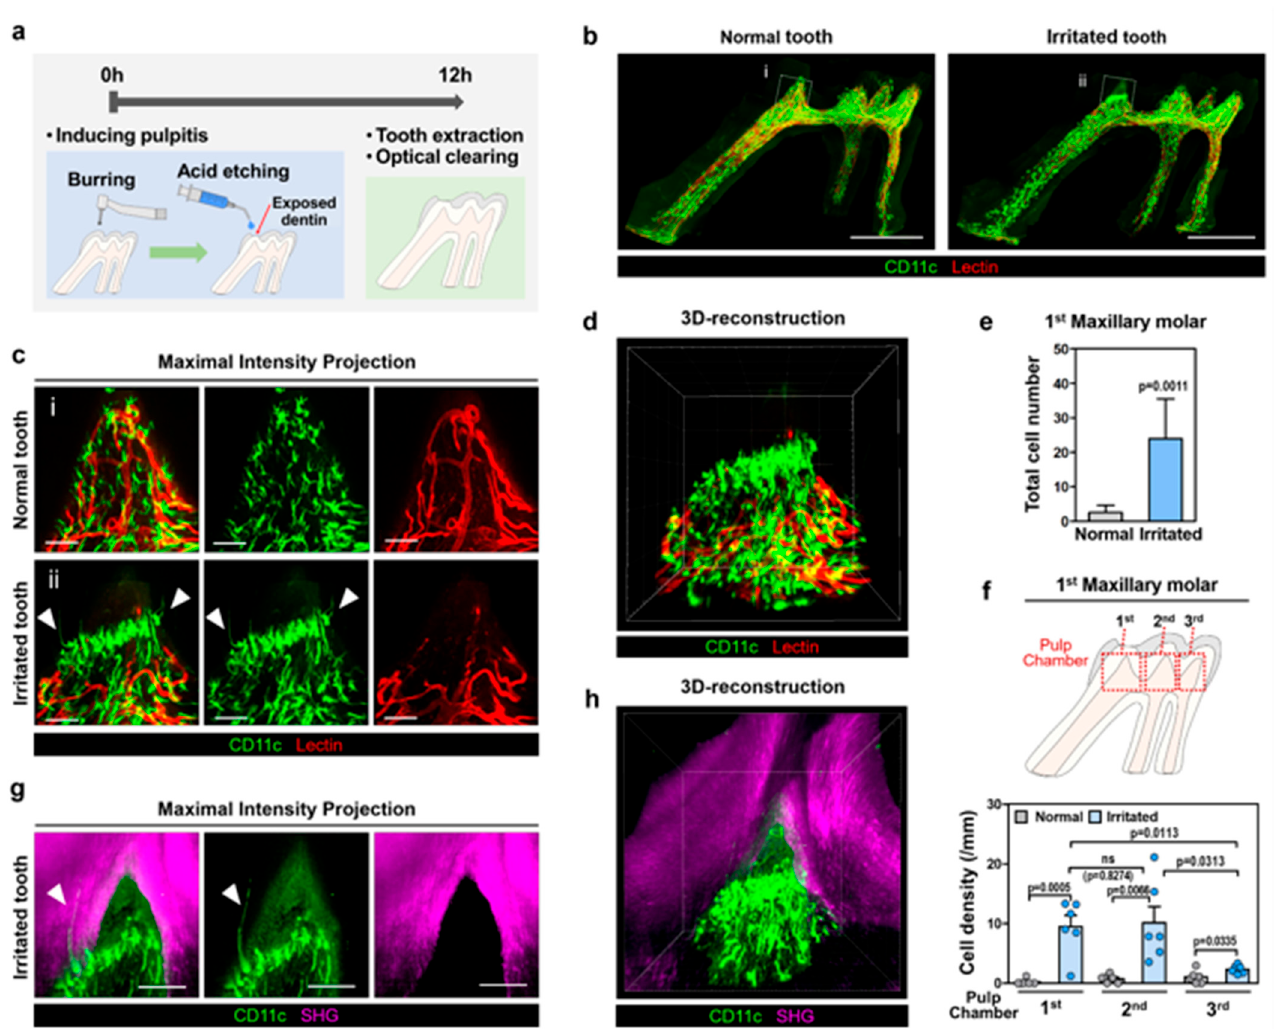
Figure 3. 3D cellular-level visualization and quantification of CD11c+ cells after acute pulpitis induction. ( a ) Schematic illustration of acute pulpitis induction. ( b ) Maximal intensity projection images of normal and irritated tooth extracted from CD11c-YFP transgenic mouse showing CD11c-YFP cells (green) and vessels labeled by intravenously injected tomato lectin (red). Scale bar, 500 μ m. ( c ) Magnified images from dotted box in ( b ). Arrowheads mark CD11c+ cells at dentin-pulp interface. Scale bar, 50 μ m. ( d ) 3D reconstructed image of the irritated tooth in ( c ) (Supplementary Video S2). ( e ) Total cell number of CD11c+ cells at dentin-pulp interface in the crown of normal and irritated teeth ( n = 6, each). ( f ) Cell density of CD11c+ cells at dentin-pulp interface in 1st, 2nd, 3rd pulp chamber compartment in normal and irritated teeth ( n = 6, each). Statistical analysis for the comparison between normal and irritated tooth was conducted with unpaired two-tailed t-tests. Statistical analysis for the comparison between pulp chamber compartment in irritated teeth was conducted with paired two-tailed t-test. ( g ) Maximal intensity projection images of the irritated tooth in ( c ) with SHG signal (magenta) of dentinal collagen. Arrowhead marks CD11c+ cell at dentin-pulp interface. Scale bar, 50 μ m. ( h ) 3D reconstructed image of ( g ) (Sup- plementary Video S5).